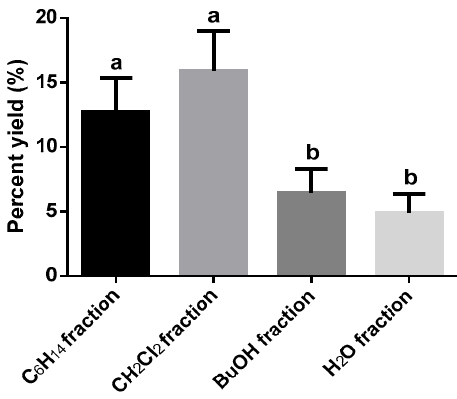
Figure 2. Berberis goudotii extract fractionated (Yields percent). n = 3 determinations. ANOVA with Tukey HSD test post hoc was used to identify differences between groups, means with the same letter are not significantly different ( p > 0.01). Total dry extract yield = 18.6 ± 1.6%.